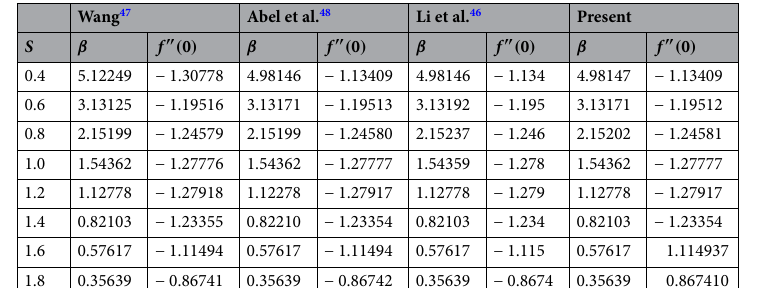
Table 5. The numerical results with the published work for M , K , and φ